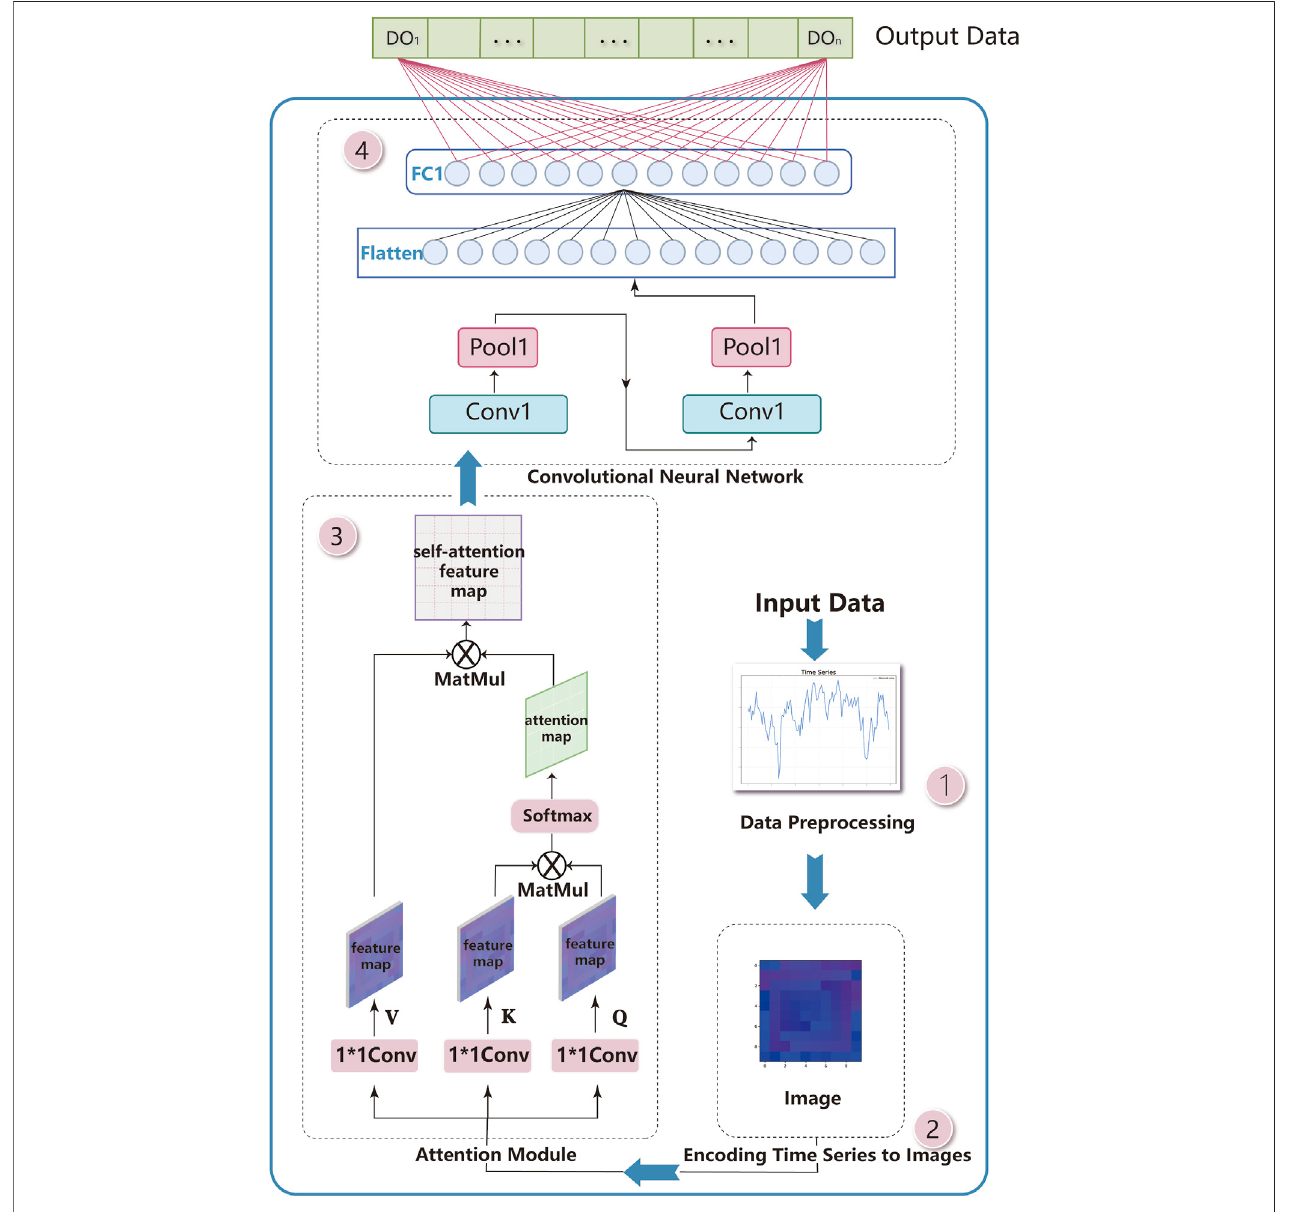
FIGURE 5 | Flow chart of DO